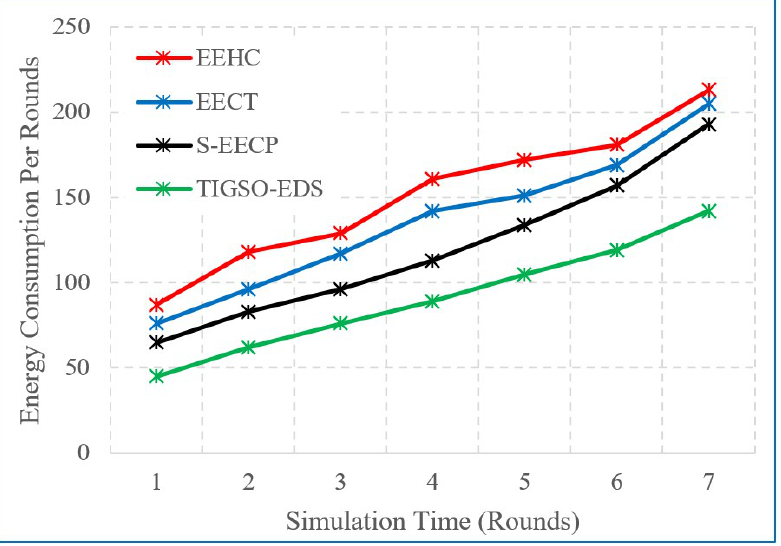
Figure 9. Energy consumption of different methods (base station located at 100 ×